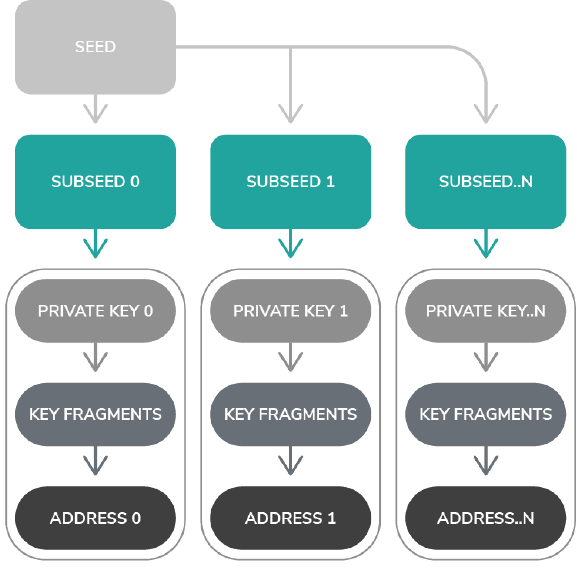
Figure 4. Generation of private and public keys from a single string called a Seed